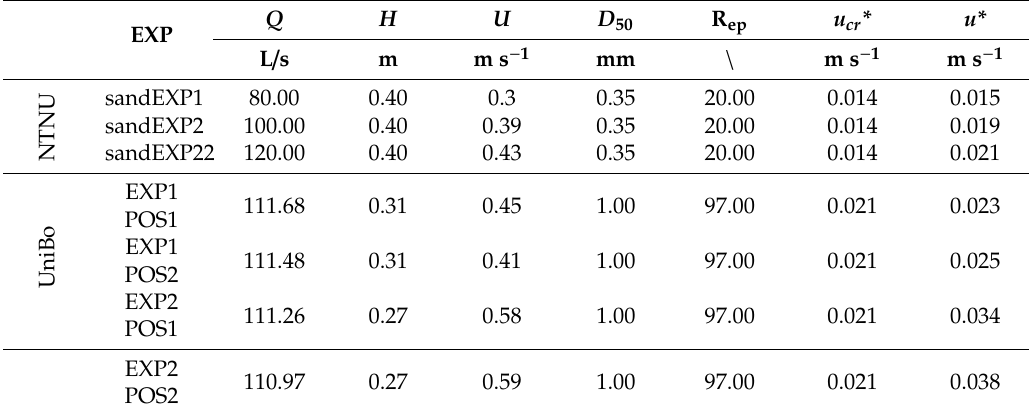
Table 1. Hydraulic